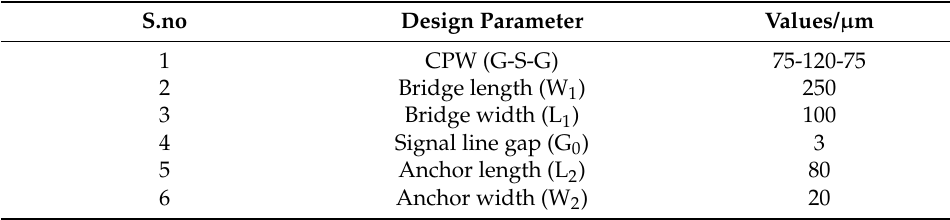
Table 1. Device structure parameters.